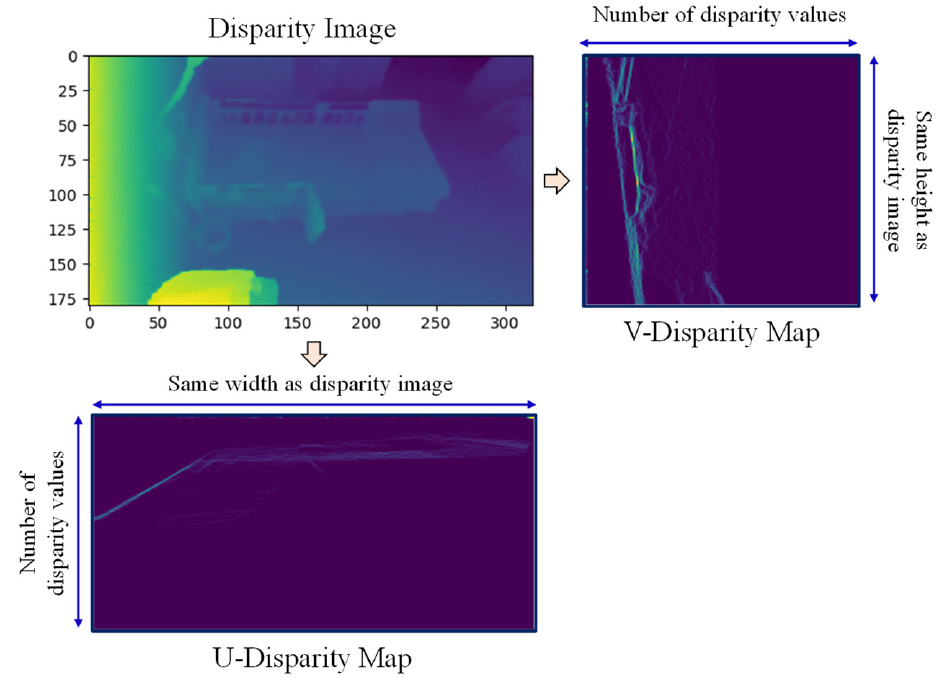
Figure 4. Disparity map to UV-disparity map conversion. The following describes the process of floor region and bed region extraction us- ing the above conversions. For extracting the floor region, the V-disparity map is used, and this process is shown in Figure 5. In the V-disparity map, the floor plane is usually simplified into a slanted straight line which is called the ground correlation line. Basically, the disparity values increase linearly along the floor plane, and the Hough line transform is used to detect this line. With this V-disparity map and the straight line corresponding to the floor plane, the pixel indices which belong to the straight line can be detected as floor pixels. After removing floor pixels, the disparity map without floor pixel values is used to extract the bed region, as shown in Figure 6a. The V-disparity map is also used for extracting the bed region, but we will not find a straight line in this approach as the bed surface is not as flat as the floor. Instead, connected component labeling is used to find the label with the largest pixel count in the V-disparity map. The assumption is that the bed has the largest area as compared to other objects in the bedroom. After that, four extreme points (minimum height, maximum height, minimum disparity, and maxi- mum disparity) are extracted from the detected label which has the maximum pixel count. We used these four points to establish the bed pixels. From the minimum to